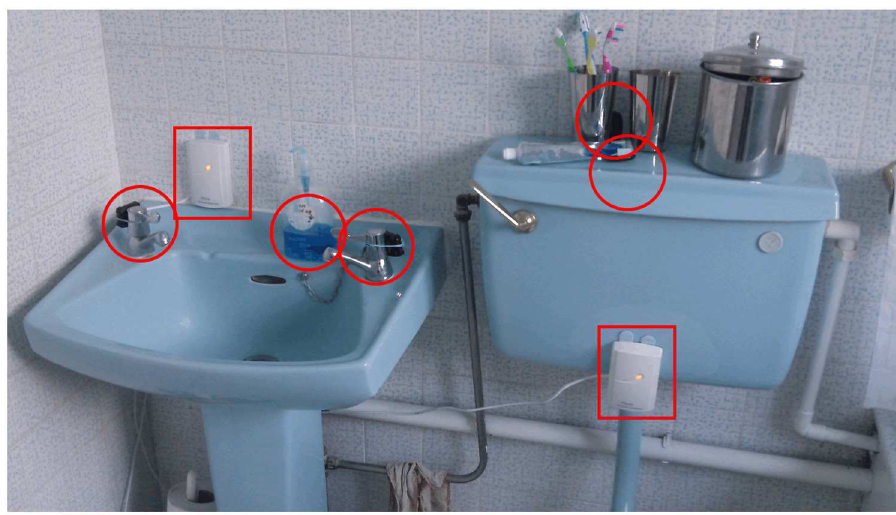
Fig 2. Elpas aystemin